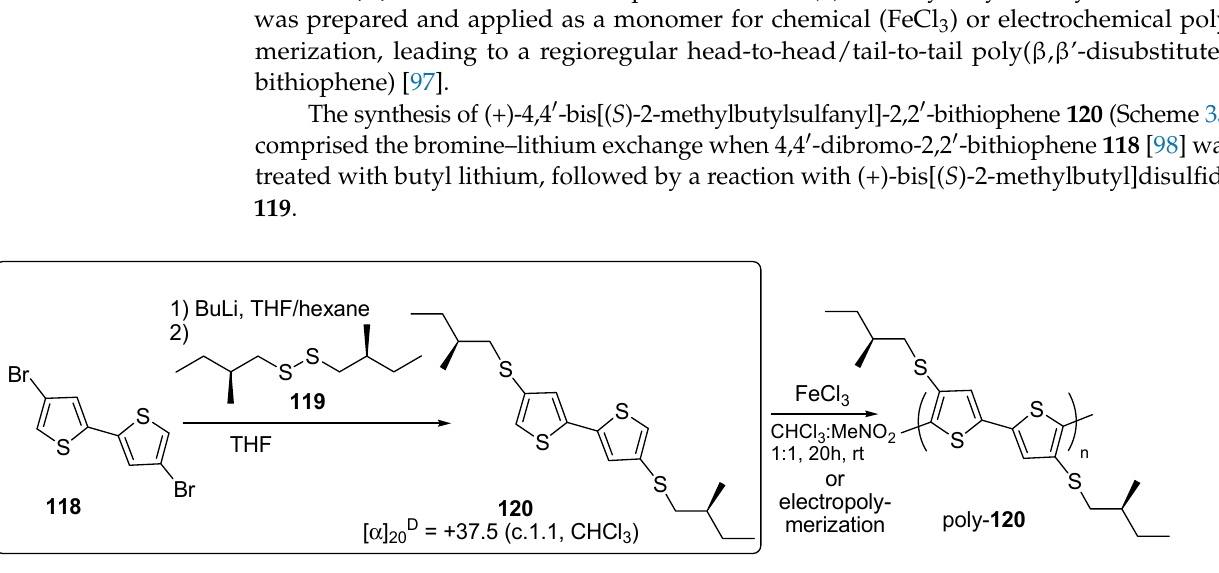
Scheme 35. Synthesis of monomer 120 and its conversion to poly[4,4 (cid:48) -bis[( S )-2-methylbutylsulfanyl]-2,2 (cid:48) -bithiophene poly- 120